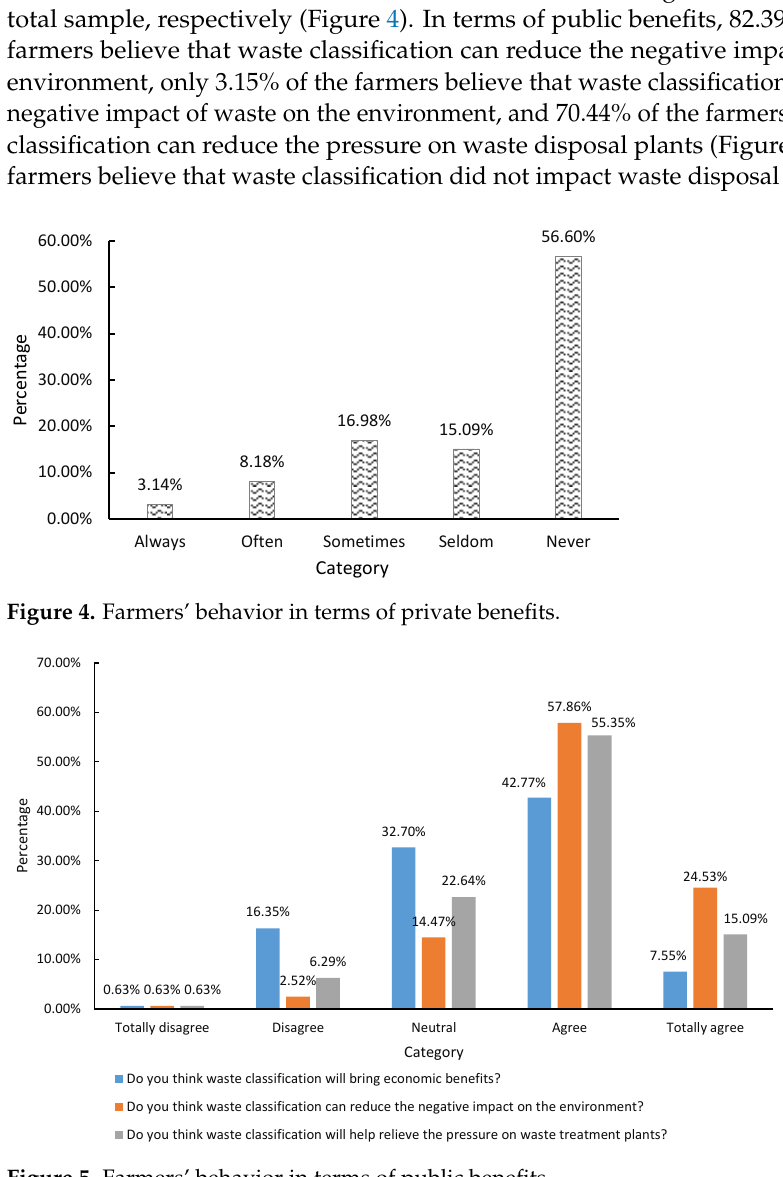
Figure 5. Farmers’ behavior in terms of public benefits.